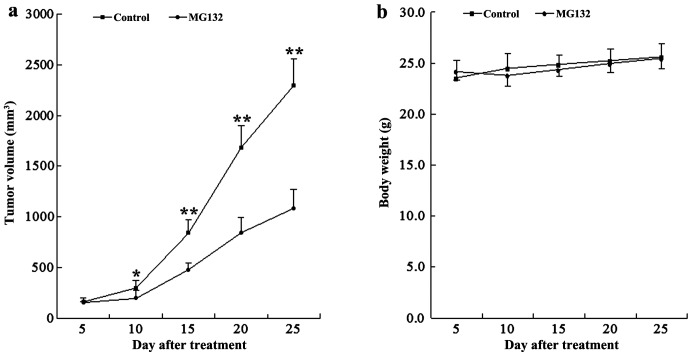
MG132 suppressed the growth of esophageal cancer xenografts. Twenty nude mice were randomly divided into two groups (n=10 per group) for treatment with MG132 [10 mg/kg, intraperitoneally (i.p.) daily] or with vehicle control solvent. (a) Average tumor volume in vehicle control mice and mice treated with MG132. Tumor volumes of xenograft mice treated with MG132 were significantly decreased compared with vehicle control assessed using the Student’s t-test (*P<0.05, **P<0.01 vs. the control group). (b) There was no statistically significant difference in body weight between vehicle control and MG132 regimen (P>0.05).